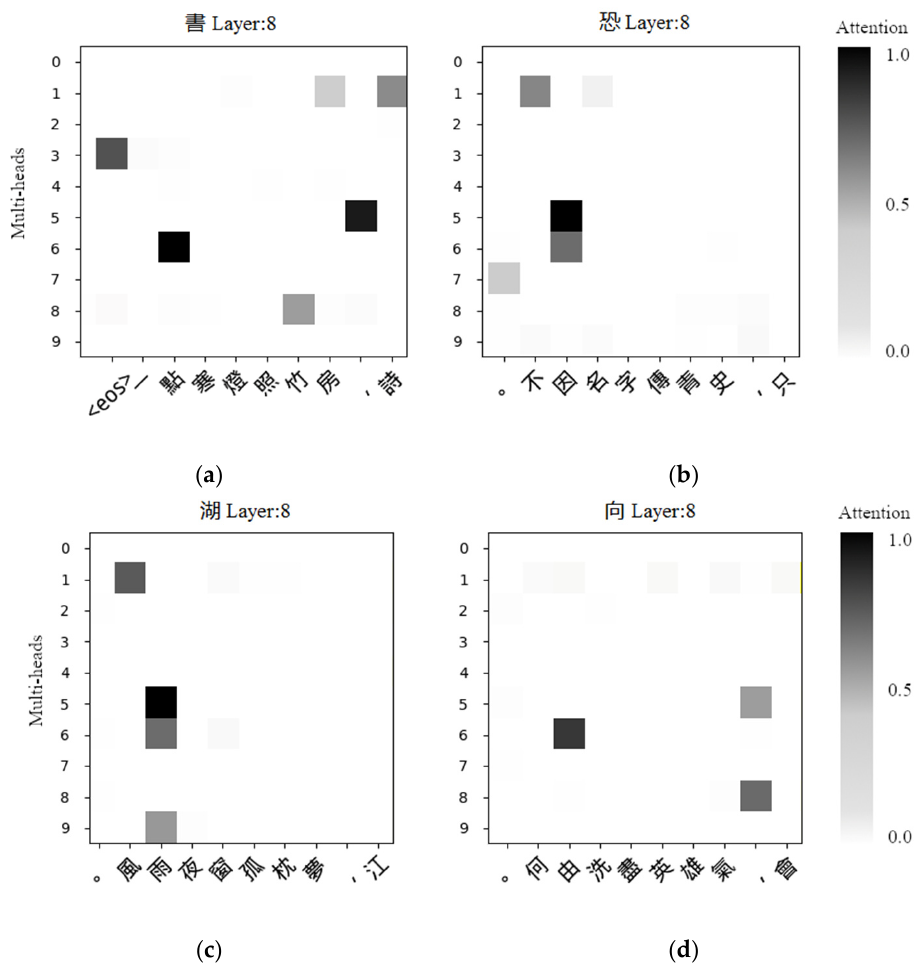
Figure 8. Visualization of the opposite-rule. ( a ) book ( 書 ); ( b ) afraid ( 恐 ); ( c ) lake ( 湖 ); ( d ) to ( 向 ). In Figure 9a, the visualization of the alike-rule shows that the second character reason ( 因 , Ping-tone) in line 3 must follow the same tone as the second character book ( 書 , Ping- tone) in line 2. In Figure 9b,c, the adjacent pairs also follow the alike-rule, in which the tone of the first sentence in the next pair must be the same as the tone of the second sentence in the previous one. After many observations of generated poems, we conclude that the head 8 or head 2 in layer 10 represents the alike-rule.